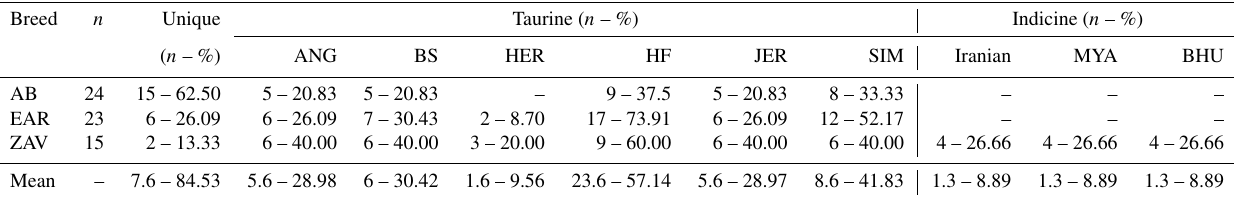
Figure 3. Neighbour joining analysis at breed level via 450bp mtDNA D-loop region sequences of NCBI database (taurine, indicine and outgroup species) and three native Turkish cattle breeds. Table 4. Admixture level of taurine and indicine breeds in native Turkish cattle